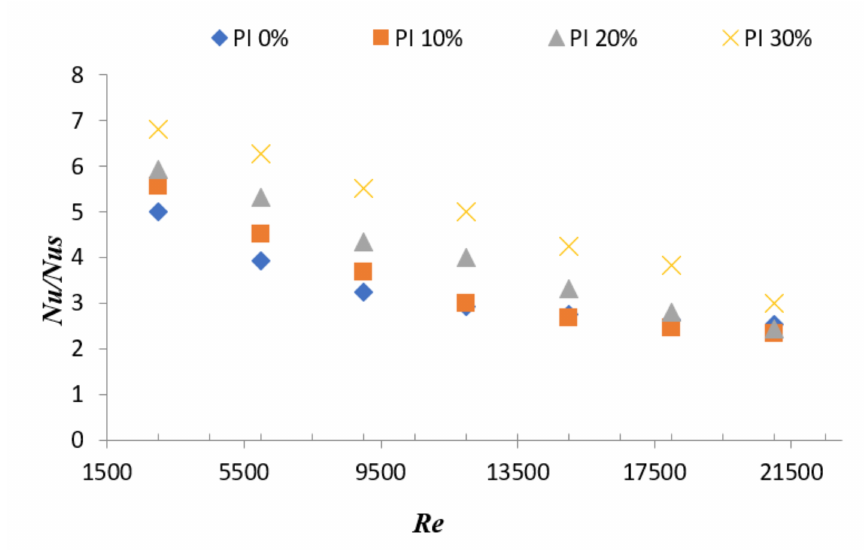
Figure 5. Variation of Nu/Nus with Re .